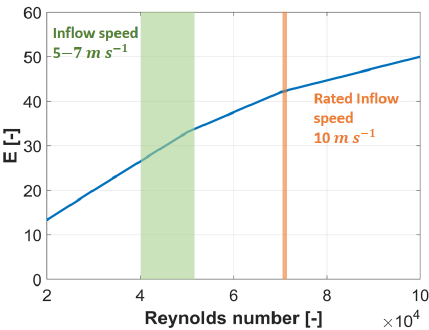
Figure 9. Aerodynamic efficiency of the RG-14 airfoil as a function of Reynolds numbers, as computed with Xfoil with solution param- eters Ncrit = 9 and M = 0 (Drela, 2022). The orange line indicates the G06 Reynolds number at rated speed. The green-shaded area in- dicates the approximate Reynolds number of waked wind turbines that operate further downstream in a column configuration at dis- tances between x/D = 3 and 5. Quantities in the figure are average values for spanwise locations between r/R = 0 . 3 and 0.9, for a TSR equal to